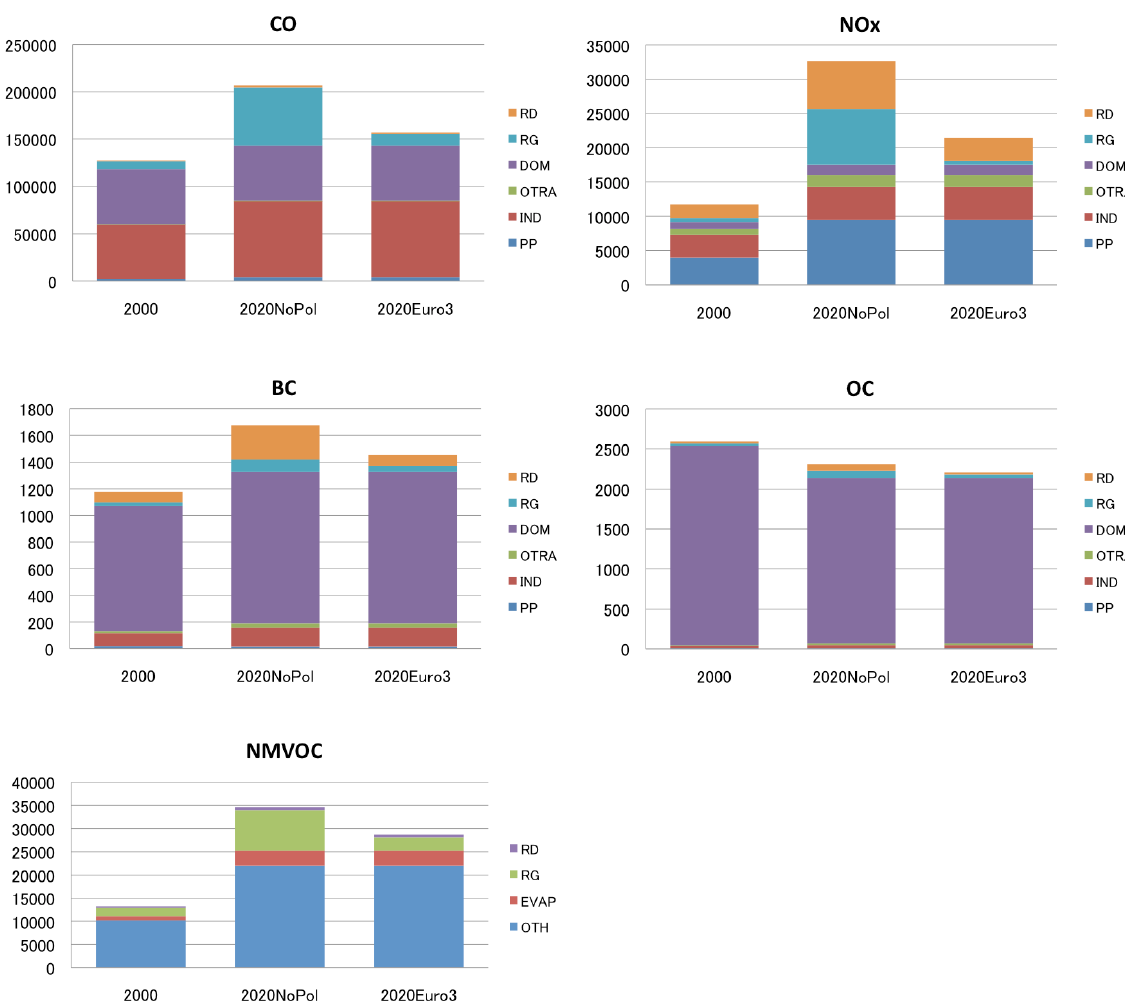
Fig. 2. Total emissions from China’s six anthropogenic sectors (RD: Road Diesel, RG: Road Gasoline, DOM: domestic, OTRA: other transport sector (airplanes, ships, etc), IND: industry, and PP: power plants, EVAP: evaporative emissions, OTH: others – waste treatment, surface emissions of aircraft and ships) in the three scenarios (2000, 2020NoPol, and 2020Euro3) upper-left CO, upper-right NO x , middle-left BC, middle-right OC, lower-left NMVOC (Ggyr − 1 ).